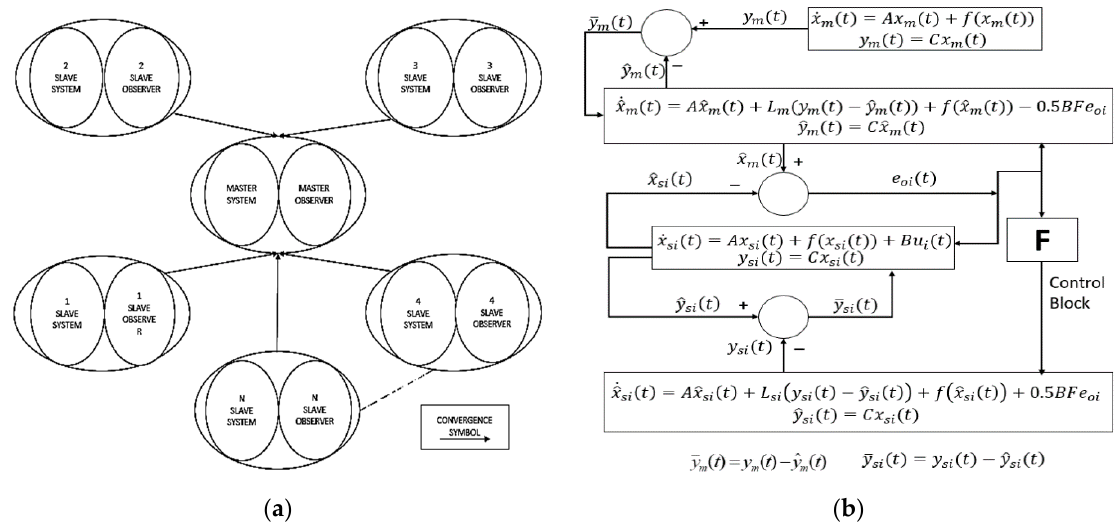
Figure 1. ( a ) Architecture of the master and N-slave systems with their corresponding observers; ( b ) block diagram of the master and slave systems with respect to their observers.